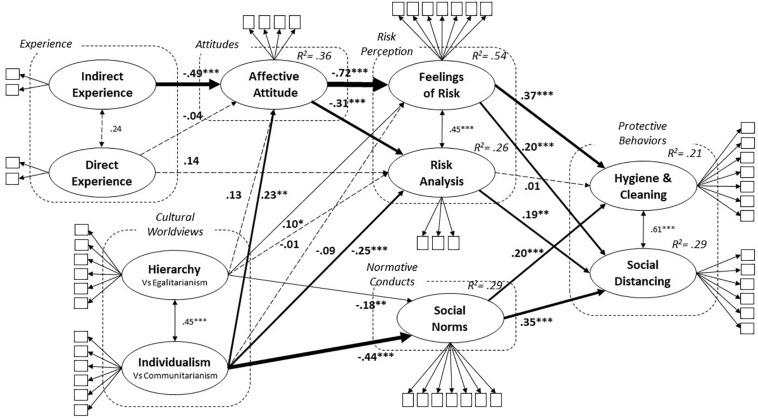
The COVID-19 Risk Perception and Protective Behavior Model with standardized path coefficients for causal paths represented by straight single-headed arrows. Non significant correlations among exogenous variables omitted. Coefficients flagged with asterisks are significantly different from zero, *p < 0.05, **p < 0.01, ***p < 0.001.